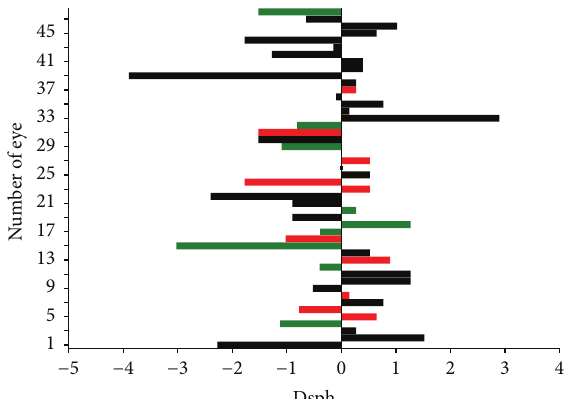
Figure 2: Refractive error. On the vertical axis: number of the eye. On the horizontal axis: refractive error in spherical equivalent. Green bars: eyes with iris/IOL complications and abnormalities; red bars: eyes with deceleration of CDVA.